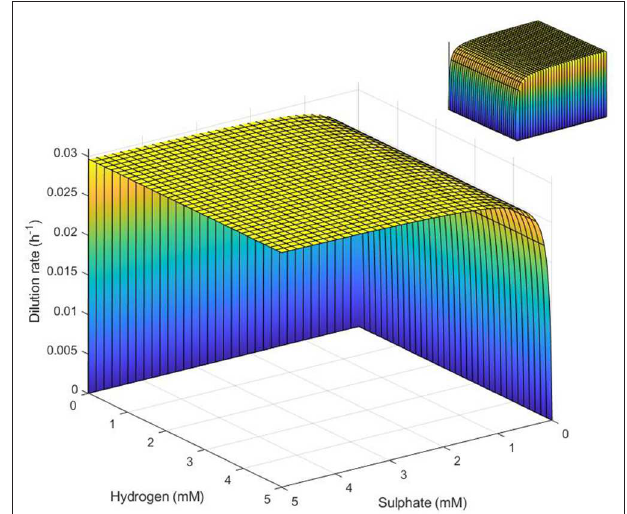
FIGURE 5 | Comparison of steady state hydrogen concentrations achieved by the methanogen and the reductive acetogen. The hydrogenotroph with the lower of the two steady state hydrogen concentrations at a given dilution rate will outcompete the other for this substrate and survive while the other is washed out. Beyond D = 0.1042, the methanogen growth rate cannot be greater than the dilution rate, so it is washed out irrespective of the presence of the acetogen.